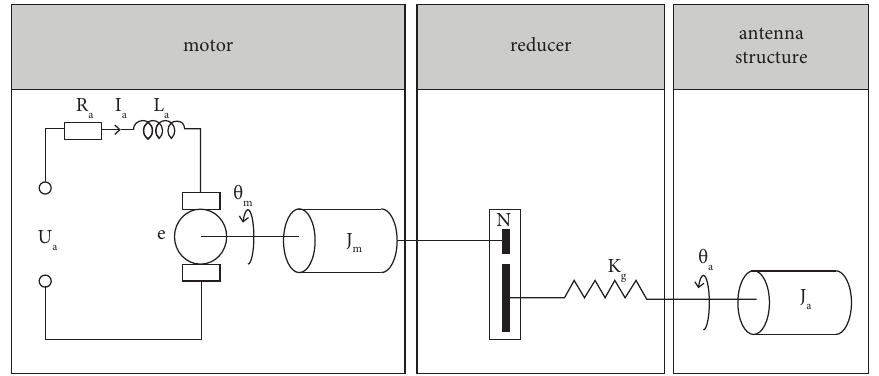
Figure 1: Main components of the antenna servo control system and their relationship.